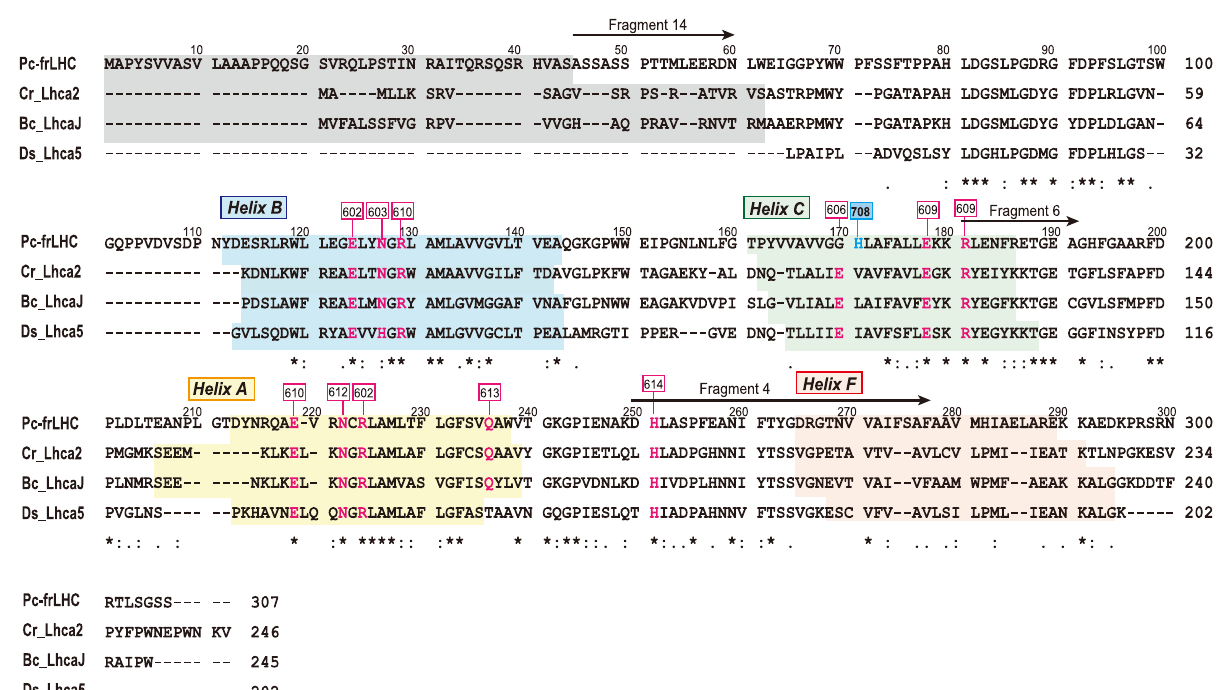
member of LHCI, while it transfers excitation energy to PSII. Transmembrane helices are shaded in different colors, the signal peptides are shaded, chlorophyll- binding sites (followed by the nomenclature of Liu et al 32 .) are shown as red characters, and the sequences detected by N-terminal sequences are shown by arrows (The Mg 2+ in Chl606 indirectly interact with Glu via a water molecule). The signal peptides and the transmembrane helices were predicted from the 3D structures registered in the PDB (Cr_Lhca2; 6JO5, 6IJO, Bc_LhcaJ; 6IGZ, Ds_Lhca5; 6SL5) and from the results of secondary structural prediction using Jpred 4 48 and TargetP-2.0 49 . The Chl708 binding site in P. crispa is shown in